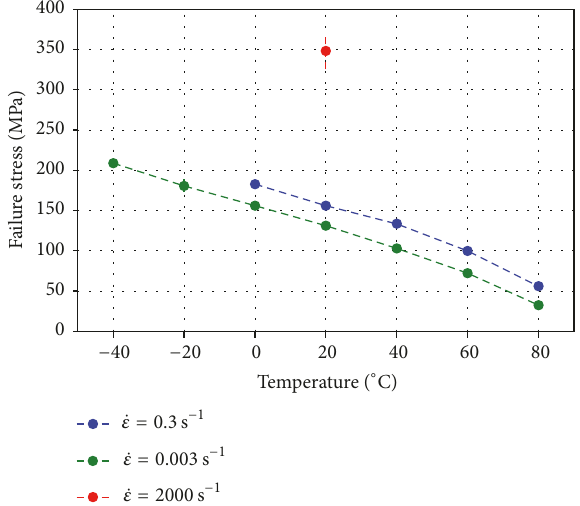
Figure 4: Failure stress of the material in compression for different strain rates and temperatures.